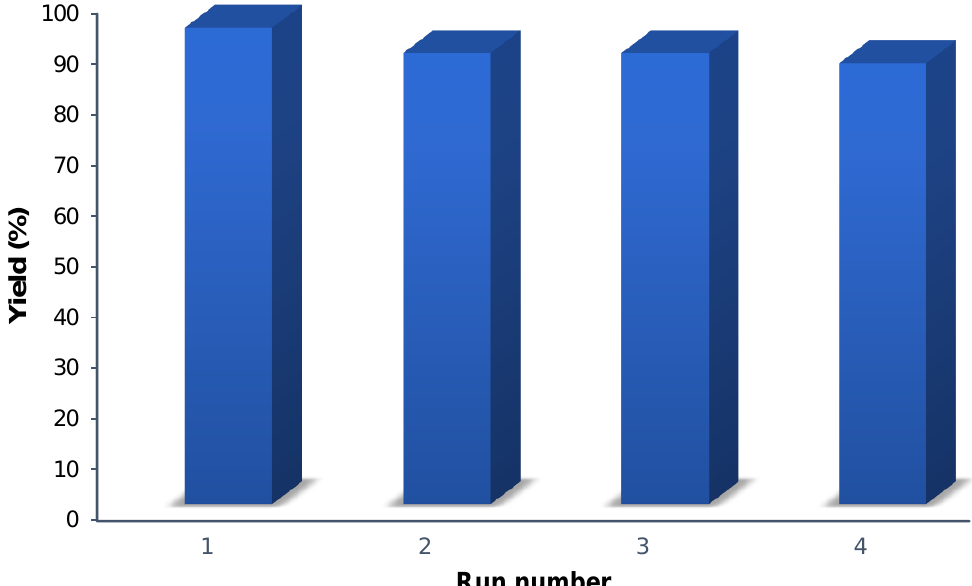
Figure 6. Recyclability test of Porph-UOZ-COF for the one-pot photo-driven tandem reaction of benzyl alcohol with malononitrile.